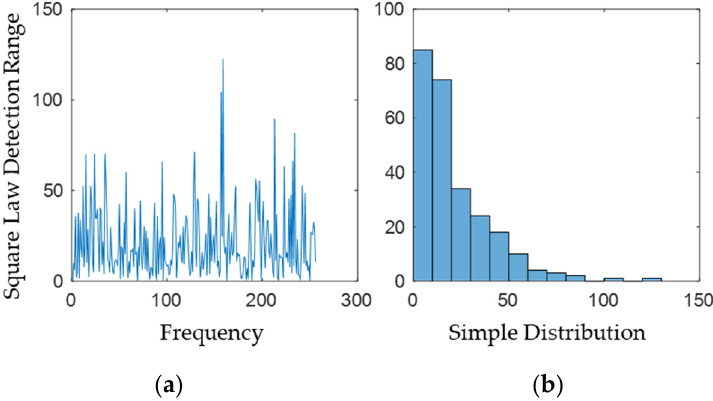
Figure 5. ( a ) Frequency and ( b ) simple distribution after square-law wave detection range.